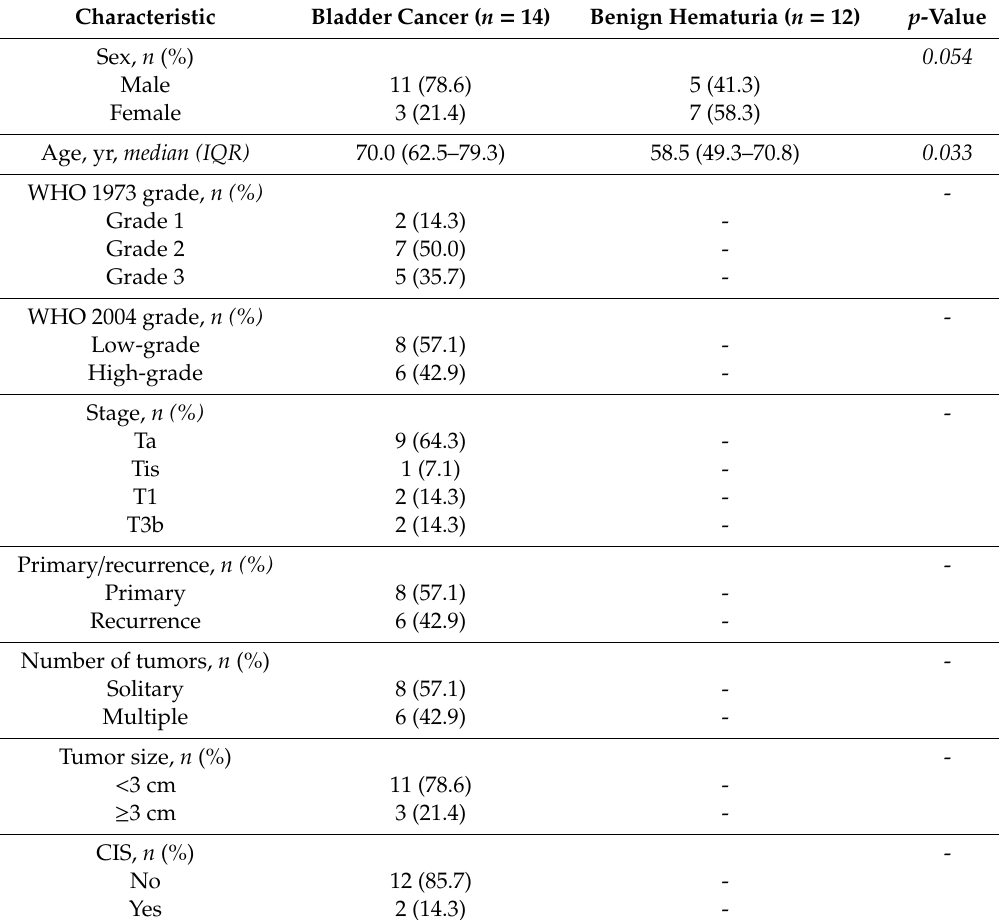
Table 1. Baseline characteristics of all included